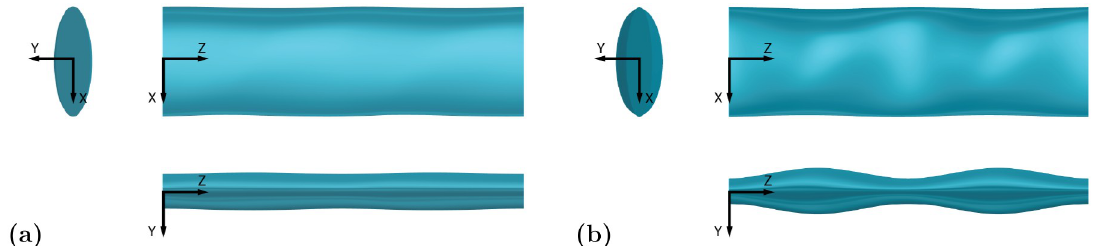
Fig 7. Geometry of models with low and high A the x - z plane, front view in the y - z plane, and side view in the x - y plane. Flow is along the positive x -axis. (a) EL1 (low A T ). (b) EL2 (high A T